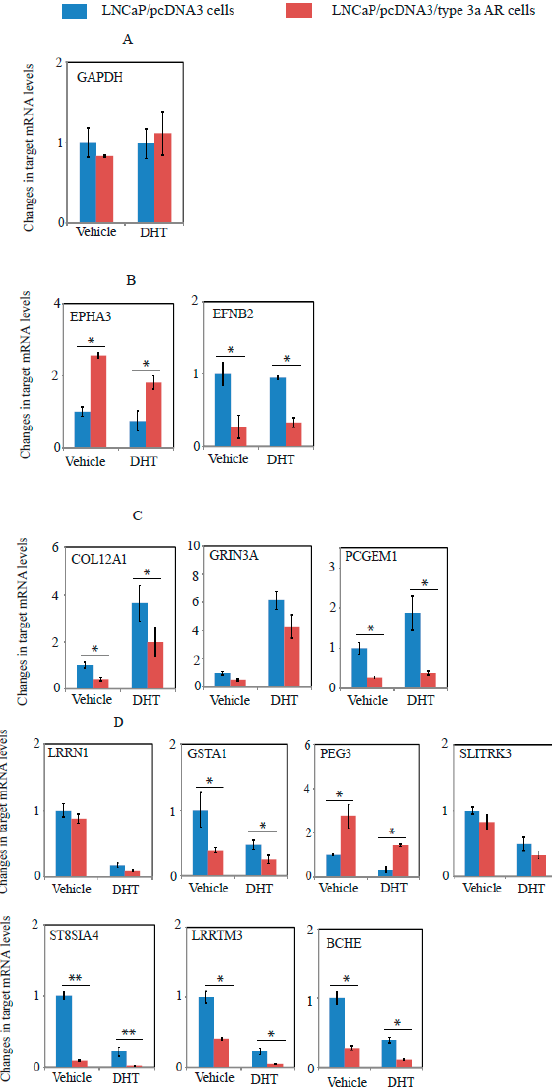
Figure 7. The expression of selected type 3a AR target genes (revealed by microarray analysis) is altered in LNCaP cells stably expressing type 3a AR (LNCaP/pcDNA3/type 3a AR) relative to control LNCaP cells (LNCaP/pcDNA3). Cells were cultured in stripped media/serum and treated with 10 nM DHT or vehicle for 24 h as described in the Methods. The expression level of each target gene in LNCaP/pcDNA3/type 3a AR cells with or without DHT is shown as the fold change relative to control LNCaP/pcDNA3 cells treated with vehicle (set to a value of 1). Shown are genes that are not affected by DHT ( A and B ), upregulated by DHT ( C ), and downregulated by DHT ( D ). Data shown are means ± SEM of three independent experiments. Statistical analysis used the SPSS program to perform t tests, p < 0.05 (*), p < 0.01 (**).